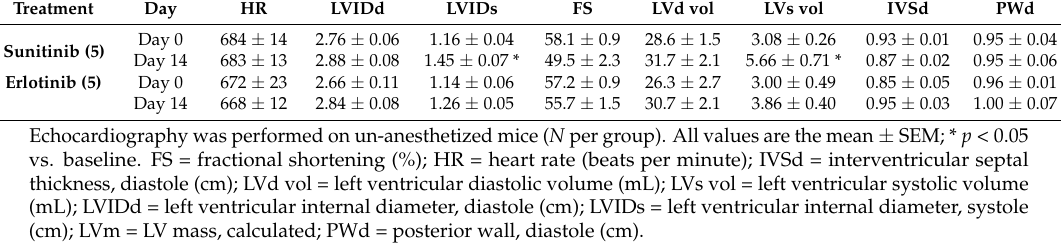
Table 1. Echocardiographic parameters after erlotinib or sunitinib treatment.